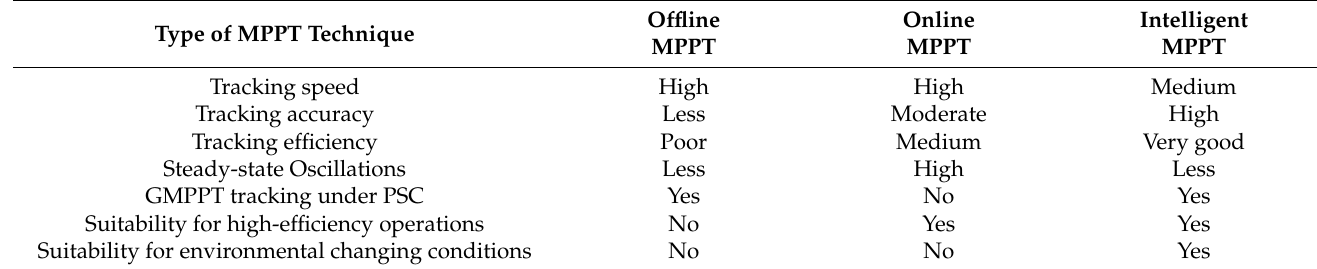
Table 6. A comparative assessment of MPPT